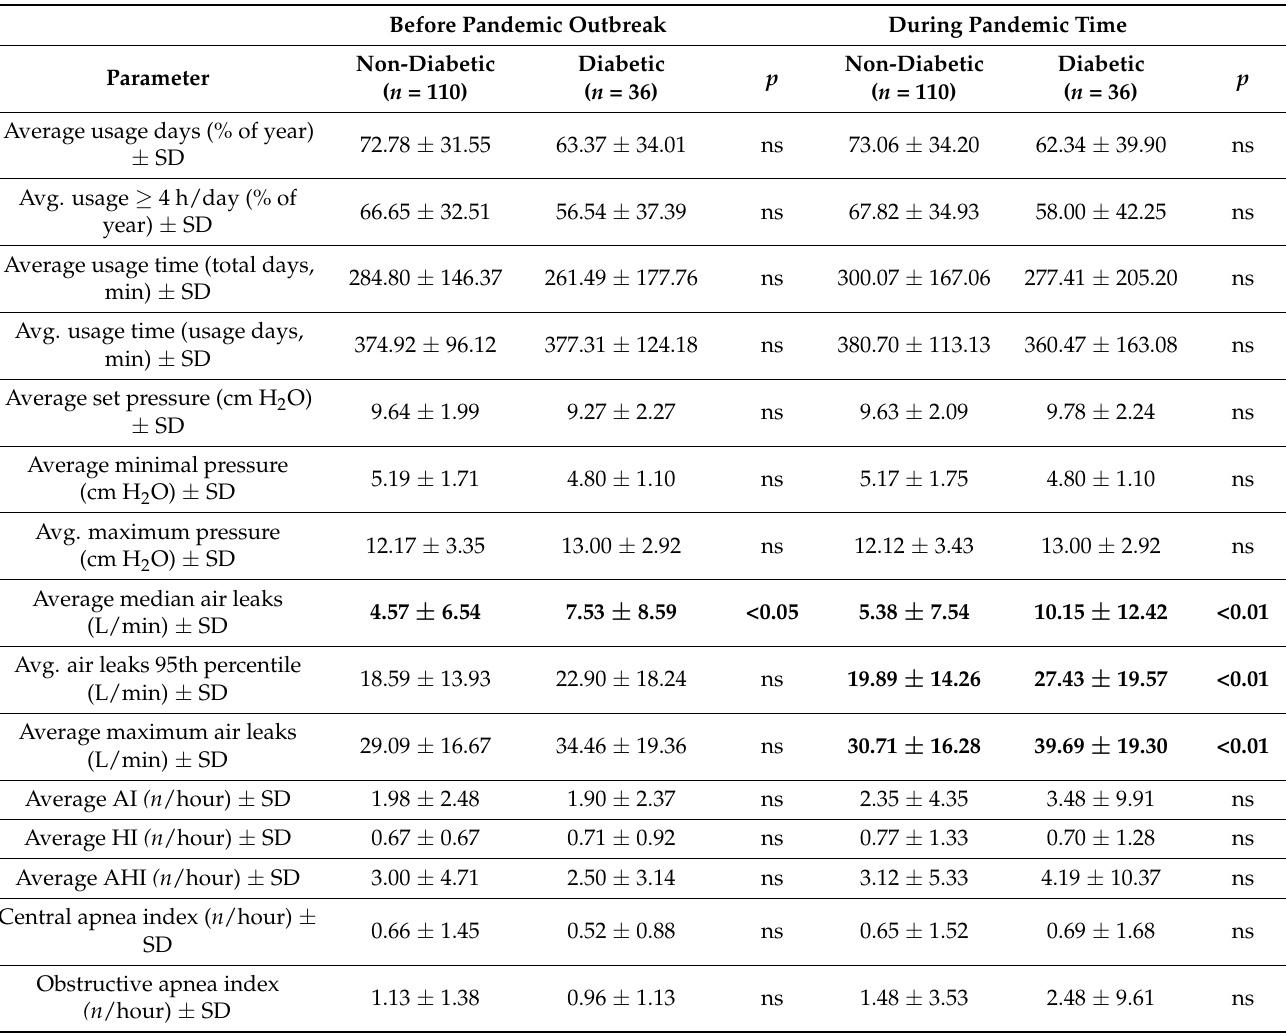
Table 6. CPAP therapy parameters and therapy adherence of diabetic and non-diabetic study participants before pandemic outbreak during first year of pandemic